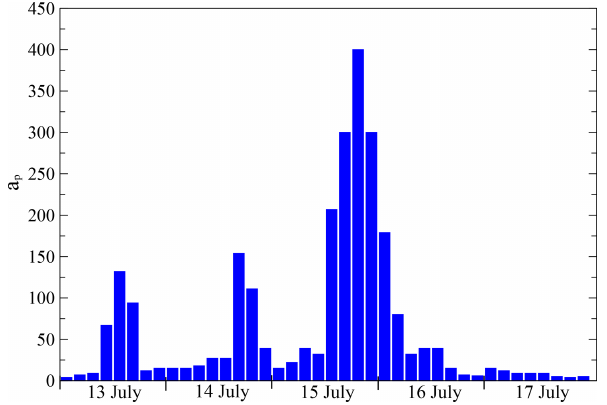
Figure 9. The 3h Ap values for 13–17 July